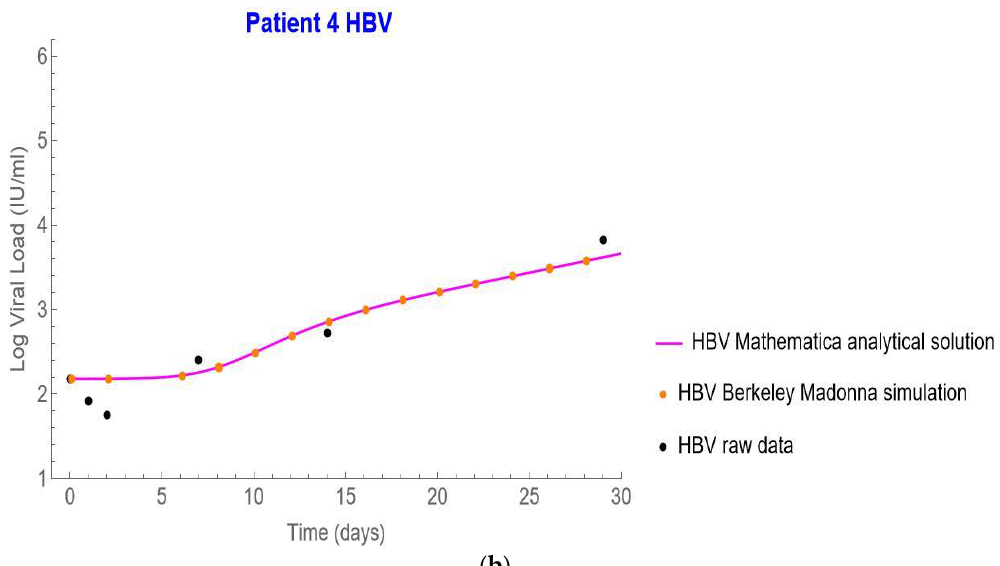
Figure 7. ( a ) shows the HBV Mathematica analytical solution (i.e., Equation (15) herein), HBV Berkeley Madonna fit for Patient 4, which is a result of fitting the modified model with measured data using Berkeley Madonna 7. ( b ) follows a similar approach as conducted in 7a but for HDV using D.